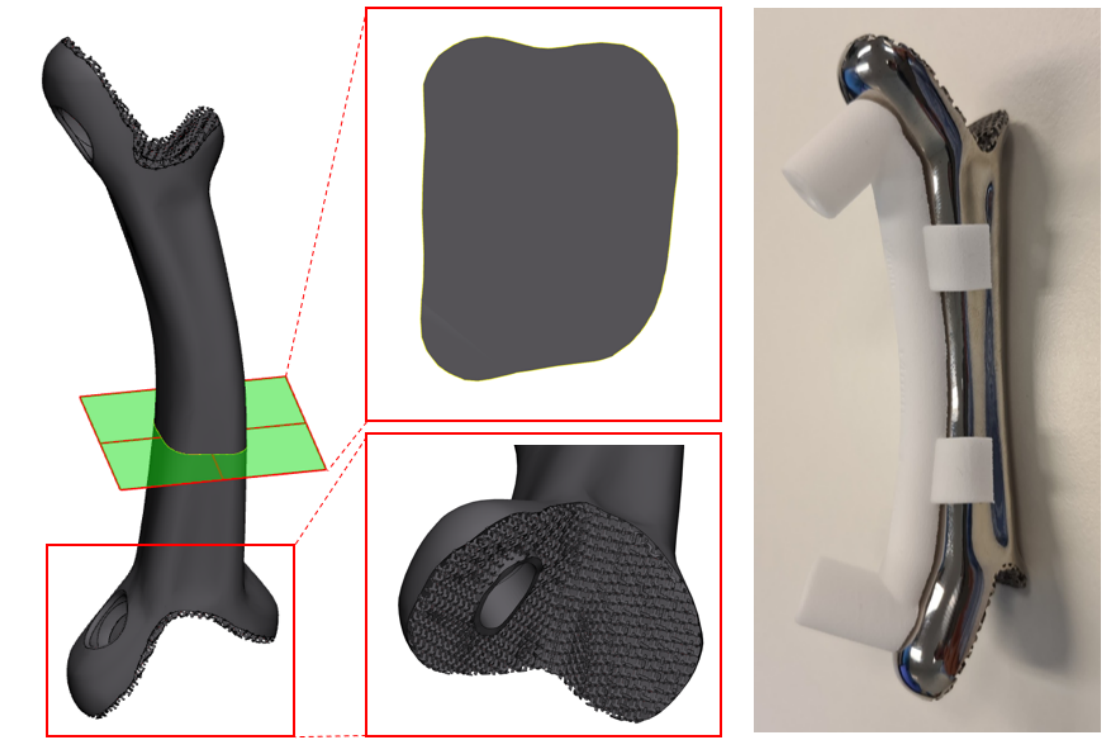
Figure 10. The implant designs. Left A rendered model of the implant. middle Cross-section ( top ) and a close-up of the porous interface ( bottom ). right The actual 3D-printed implant with a nylon drill guide attached.